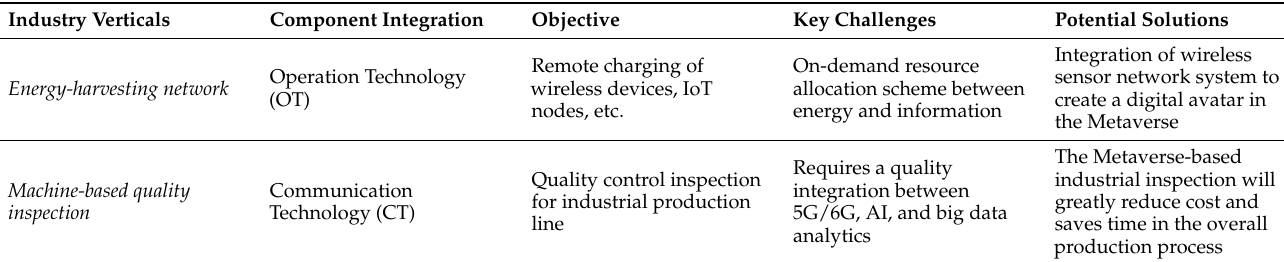
Table 5. Potential industrial applications for the